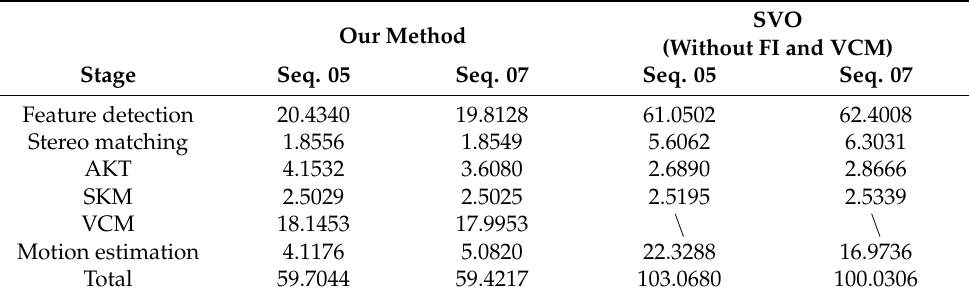
Table 3. Processing time in milliseconds of each stage for sequences 05 and 07 in the KITTI